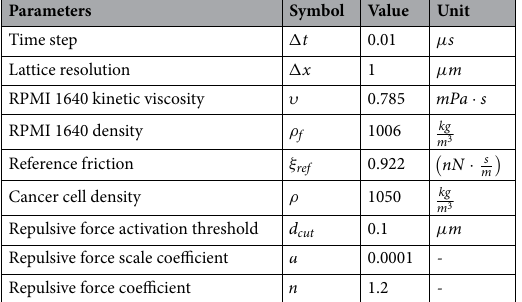
Table 3. Parameters used for modelling cancer cell deformation and motion in the